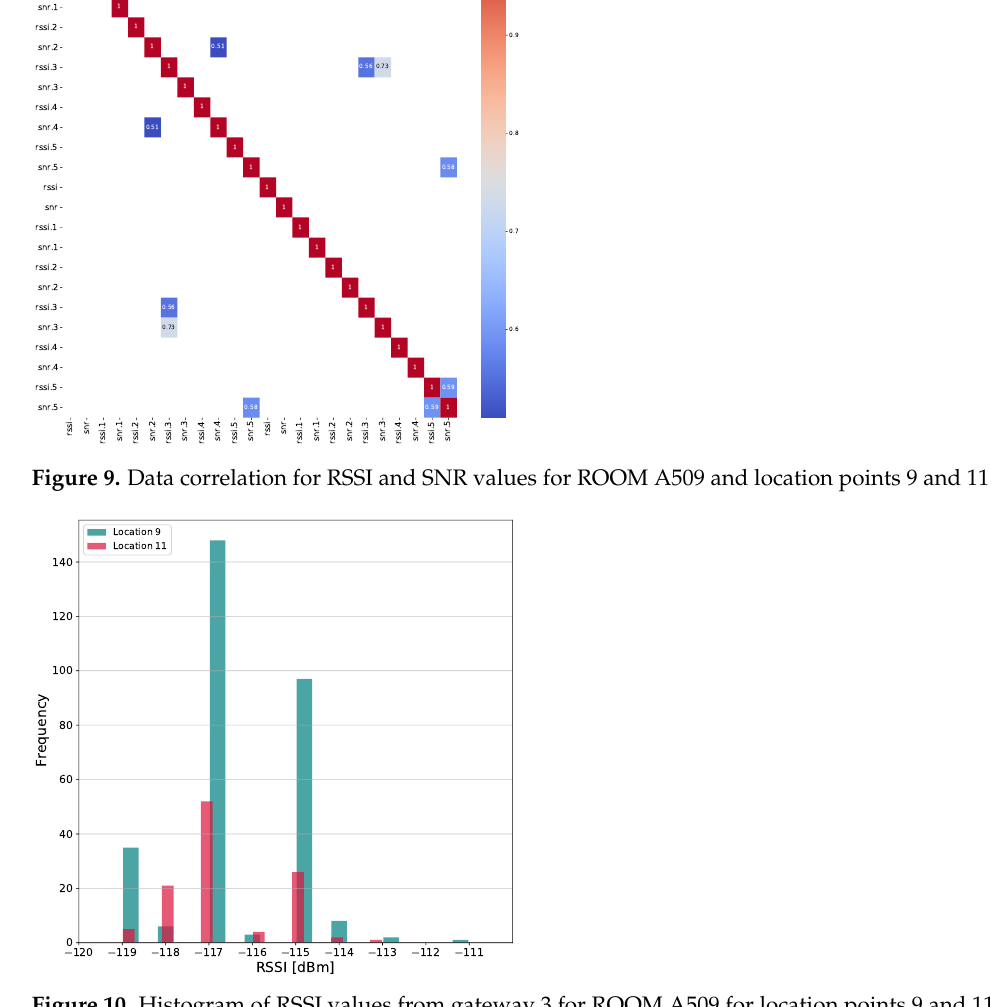
Figure 10. Histogram of RSSI values from gateway 3 for ROOM A509 for location points 9 and